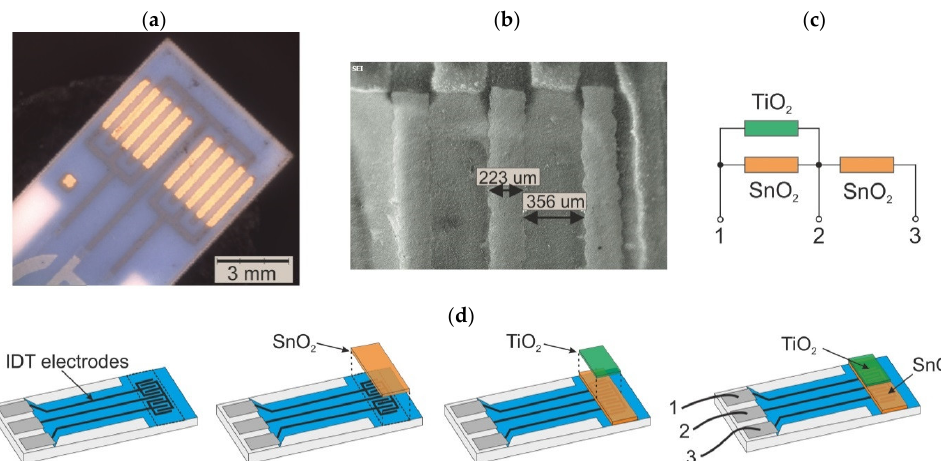
Figure 3. Gas sensor used in experiment: ( a ) SEM photograph of substrate with interdigital Au electrodes and ( b ) electrodes in magnification, ( c ) simplified equivalent circuit of the sensor, and ( d ) successive steps of gas sensor preparation, with sputtered SnO 2 layer and TiO 2 thin film deposited by the L–B technique.